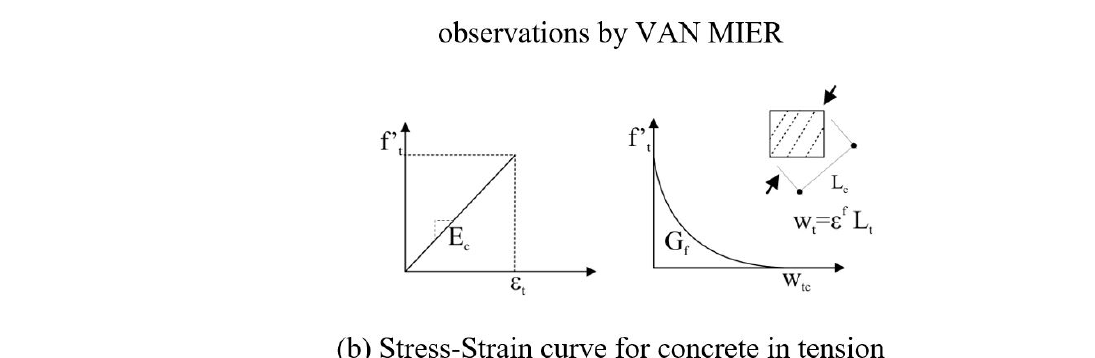
Figure 5. Fracture-plastic constitutive model of the concrete. Adapted from Cervenka et al. [23].